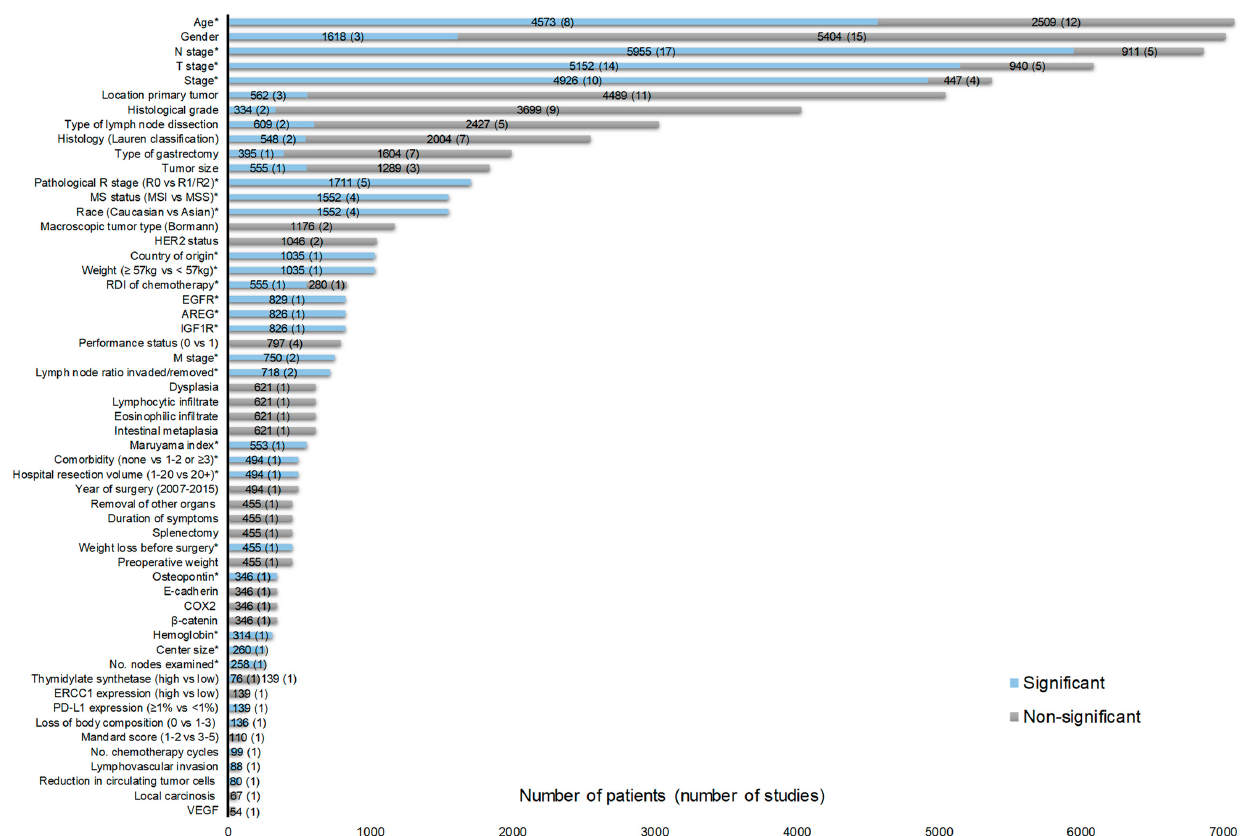
Figure 2. Prognostic factors for the curative treatment of gastric cancer identified from overall survival (OS) multivariate analyses in at least one randomized control trial (RCT). In total, there were 32 RCTs contributing to Figure 2 with 27 investigating adjuvant therapy [4–6,19–27,29–32,34–37,39–43,45,49,52,53] and five